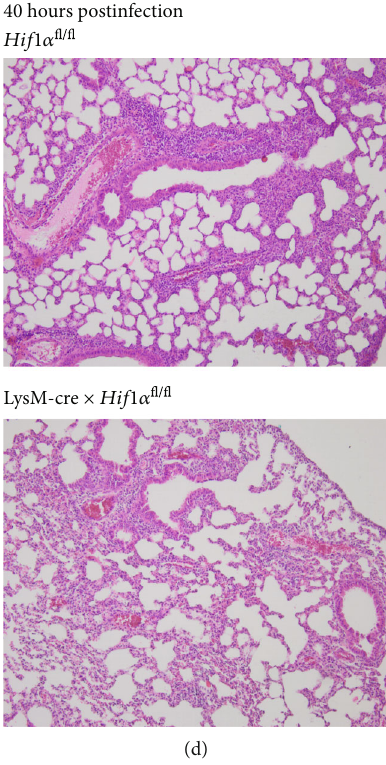
Figure 3: Pathology of the lungs after K. pneumoniae infection. Cytokine levels (TNF, IL-1 β , IL-6, and IL-10) in the lungs of 12-16 mice per group 12 and 40 hours after infection with K. pneumoniae (a). The extent of in fl ammation in the lungs of LysM-cre × Hif1 α fl / fl mice and littermate controls scored on haematoxylin and eosin- (H&E-) stained tissue sections as total pathology score of the infected lungs from 7- 8 mice per group at 12 and 40 hours after inoculation (b). Data are shown as box-and-whisker diagrams, and the LysM-cre × Hif1 α fl / fl mice were compared to littermate control ( Hif1 α fl / fl ) mice using the Mann-Whitney test. Representative photographs of H&E-stained tissue sections of the infected lungs from LysM-cre × Hif1 α fl / fl mice and littermate controls at 12 (c) and 40 hours